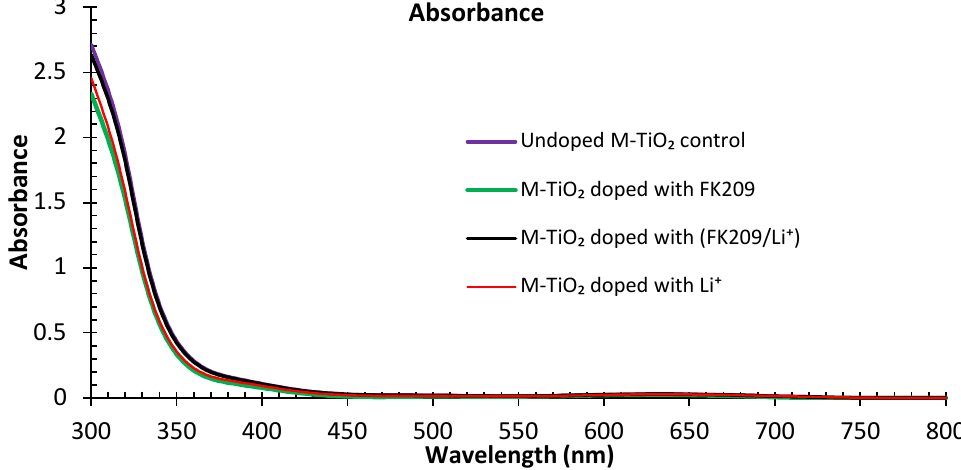
Figure 4. Optical absorbance properties of mesoporous TiO 2 doped with FK209, FK209 /Li + , and Li + .